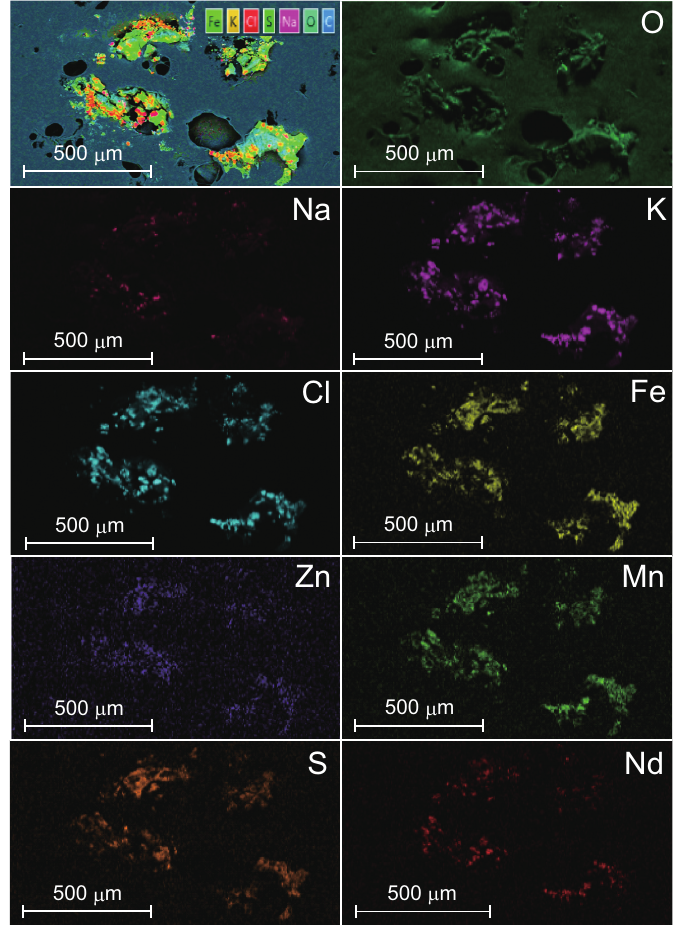
Figure 2. EDS element mapping corresponding to the SEM image of Figure 1a [19]. Elements include oxygen (O), sodium (Na), sulphur (S), potassium (K), chlorine (Cl), manganese (Mn), iron (Fe), zinc (Zn), and neodymium (Nd). Reprinted from Reference